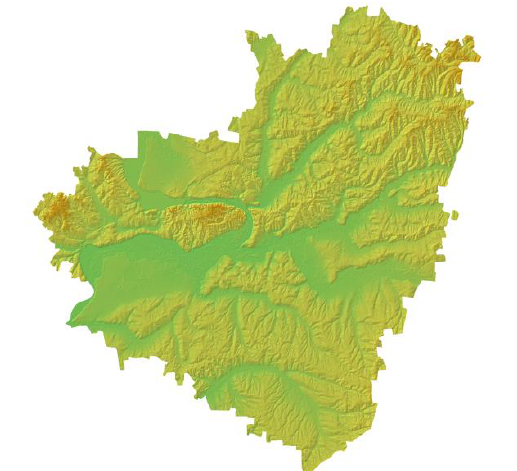
Figure 3. Merge relief with shading and color relief